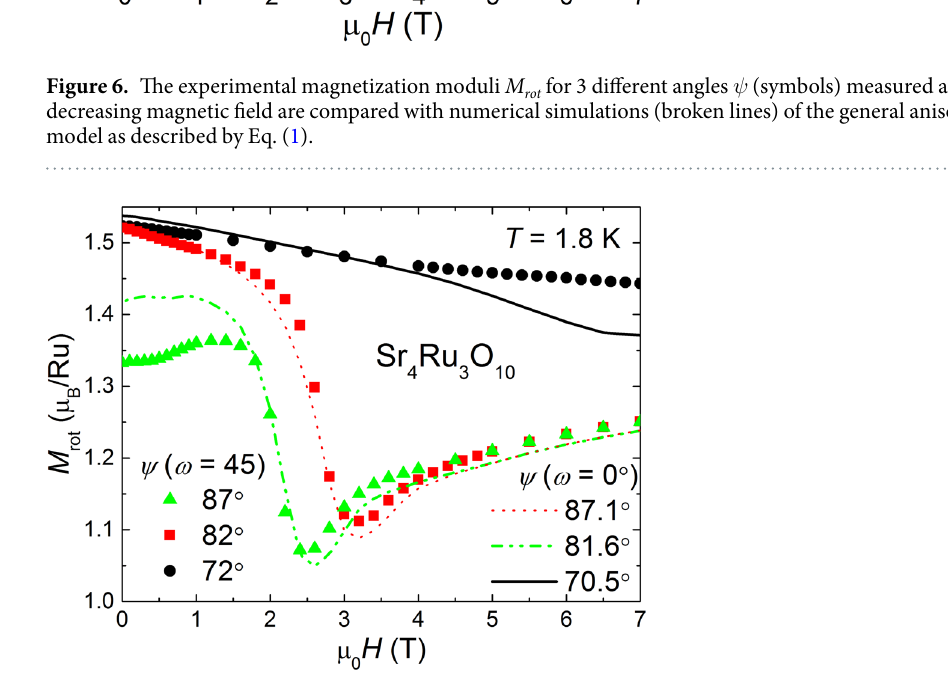
Figure 7. Decreasing field H measurements of the magnetization modulus M rot taken at 1.8 K at three angles ψ ≃ 87°, 82°, and 71° are shown for two different in-plane angles ω = 0 and 45°. The almost identical results for 0 and 45° disable magnetocrystalline anisotropy being the cause for the loss of magnetic moment in Sr 4 Ru 3 O 10